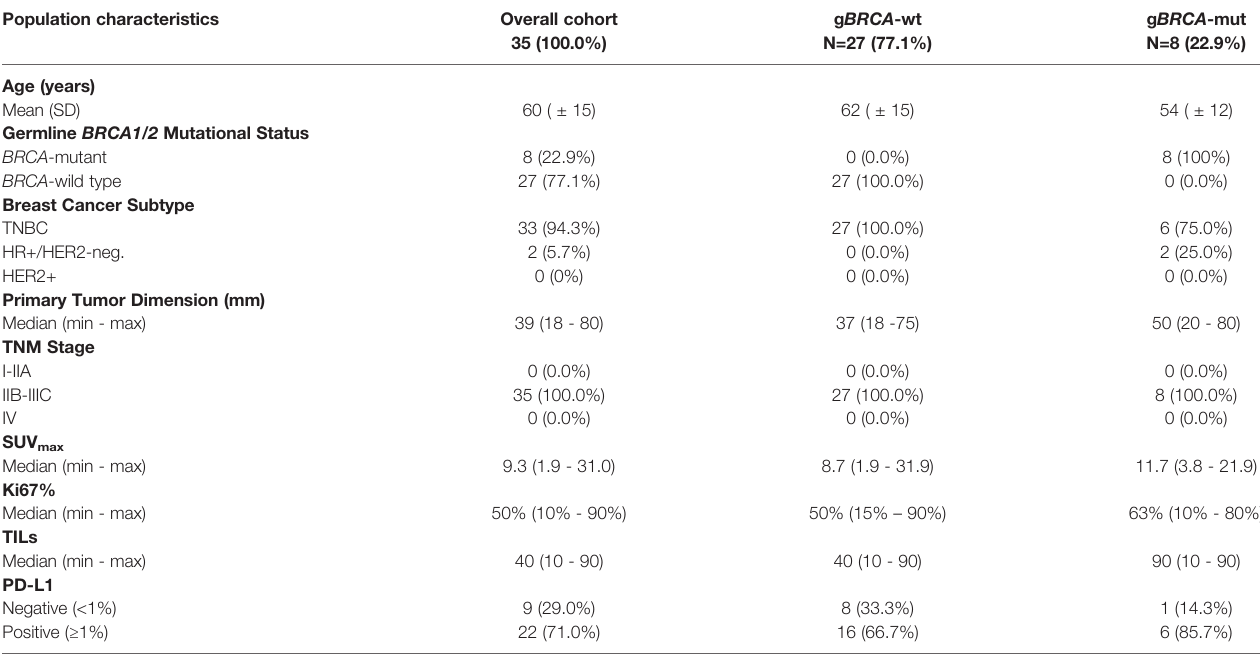
TABLE 1 | Demographics at baseline.